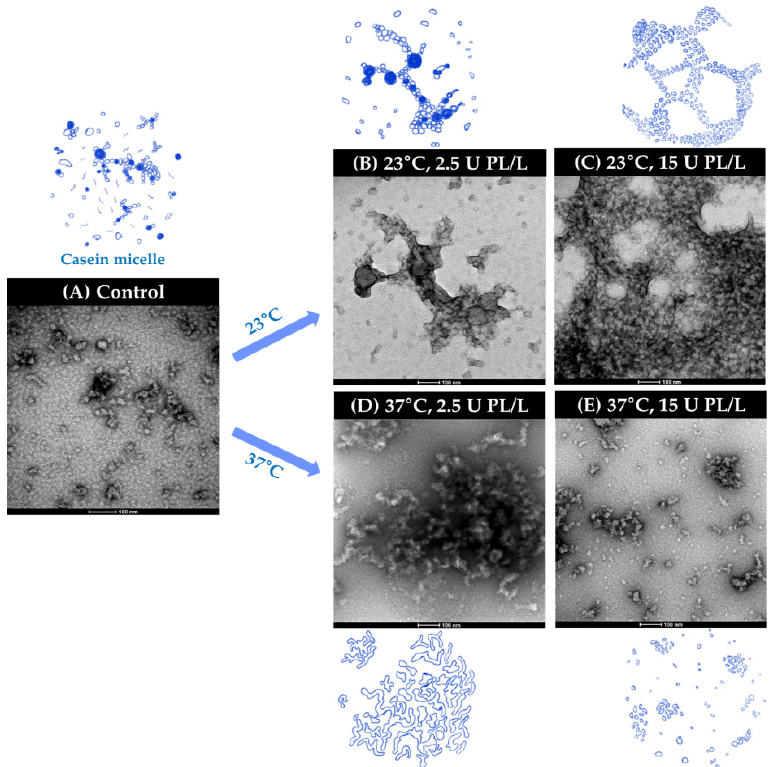
Figure 5. TEM images of PL-added UHT skim milk at different storage conditions. ( A ) Control (fresh UHT skim milk); ( B ) UHT skim milk containing 2.5 U PL/L stored for three weeks at 23 °C; ( C ) UHT skim milk containing 15 U PL/L stored for three weeks at 23 °C; ( D ) UHT skim milk con- taining 2.5 U PL/L stored for three weeks at 37 °C; ( E ) UHT skim milk containing 15 U PL/L stored for three weeks at 37 °C. UHT, ultra-high temperature; PL,